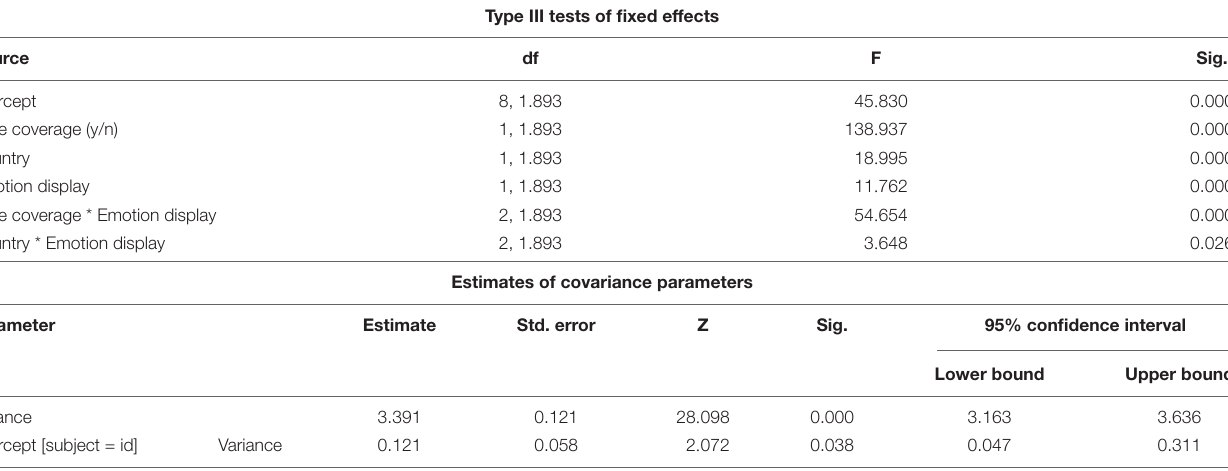
TABLE 2 | Emotion-congruent intensity